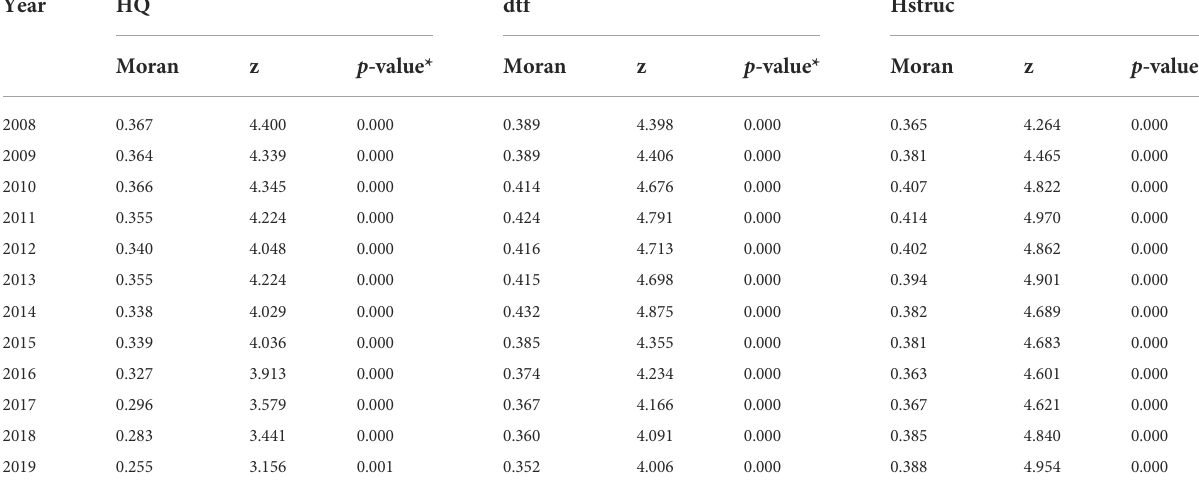
TABLE 5 Global Moran ’ s I of economic development quality, business environment, and human capital structural upgrading. Year HQ dtf Hstruc Moran z p -value*